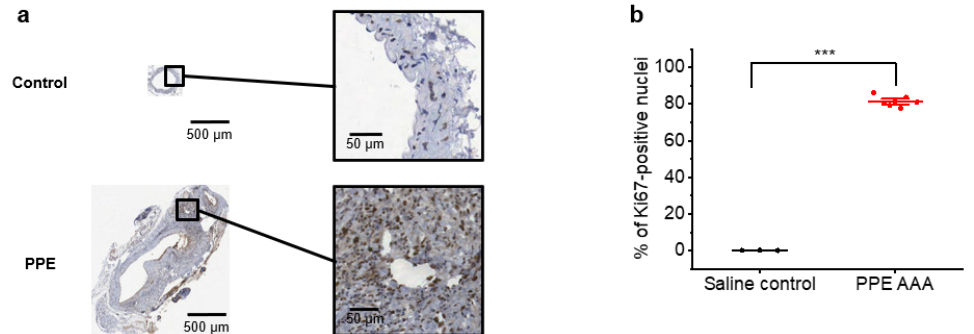
Figure 1. ( a ) Representative histological images of Ki67-stained aortic tissue from control and the PPE AAA model. Ki67 positivity is indicated by the brown colour, and a blue haematoxylin counterstain has been applied to aid visualisation. ( b ) Proportion of Ki67-positive nuclei in controls ( n = 3) and in the PPE AAA model ( n = 7). *** p < 0.001 on one-way ANOVA with post-hoc Bonferroni– Holm correction.